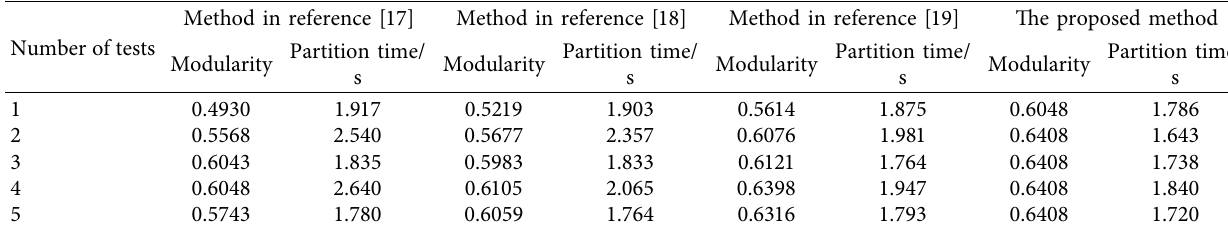
Table 2: Comparison of different clustering methods.